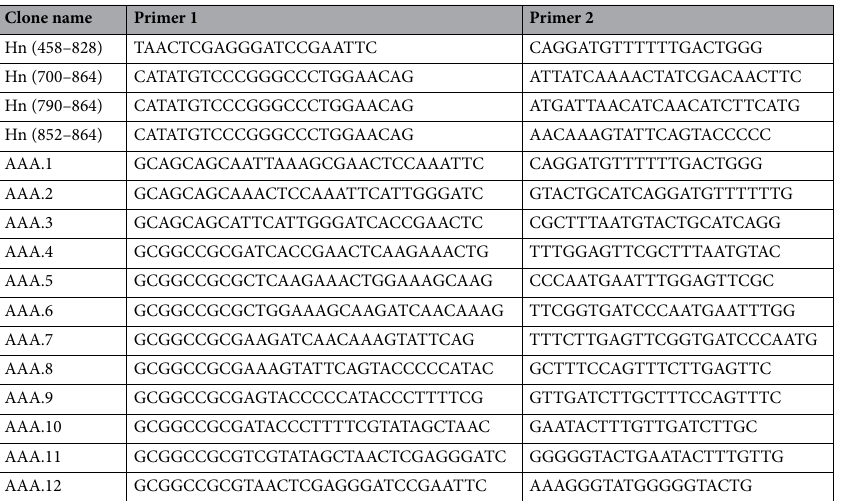
Figure 6. Docking model of Hn-reactive 8D8 with full-length TeNT. The docking model of Hn-reactive 8D8 with full-length TeNT (PDB ID: 5N0B) was obtained by using SnugDock software contained in Rosetta software suite (version 2020.37) (http:// www. roset tacom mons. org/). The 3-D structure of the variable domain of 8D8 was predicted by using RosettaAntibody software. A whole structure view and a close-up view of 8D8 and TeNT are shown by ribbon models, and experimentally determined binding sites (NSKFIGITE and LES) are shown by stick models with 3-letter amino acid codes and numbers. CDR loops in V L and V H of 8D8 are indicated with green and blue, respectively. Lc, Hn, and Hc domains in TeNT are indicated with cyan, orange, and red, respectively. Hydrogen bonds are indicated with cyan lines. Antibody-antigen interaction sites within a 5 Å distance are indicated with black dashes.